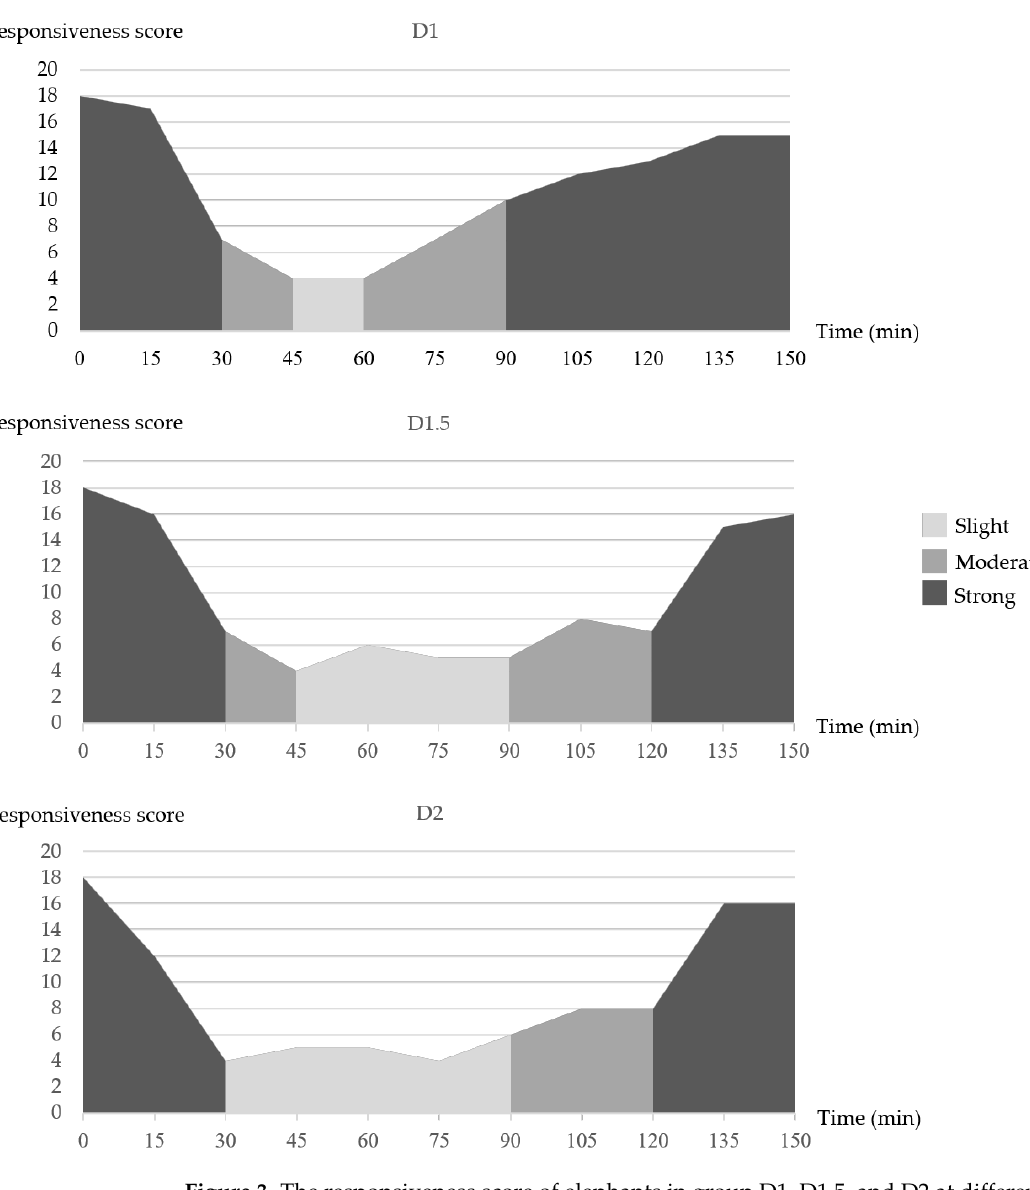
Figure 3. The responsiveness score of elephants in group D1, D1 . 5, and D2 at different time points